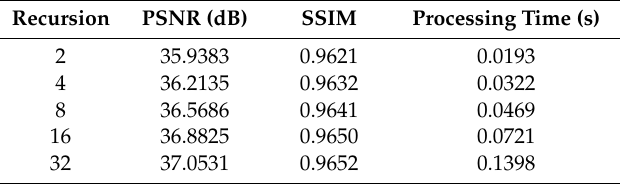
Table 1. Model comparisons at di ff erent recursion numbers in terms of PSNR and SSIM on the COWC datasets for the scale factor × 2. The deeper model with more recursions achieved a better performance because of the larger conceptive fields and more nonlinearities, while the processing time per tile also increased.